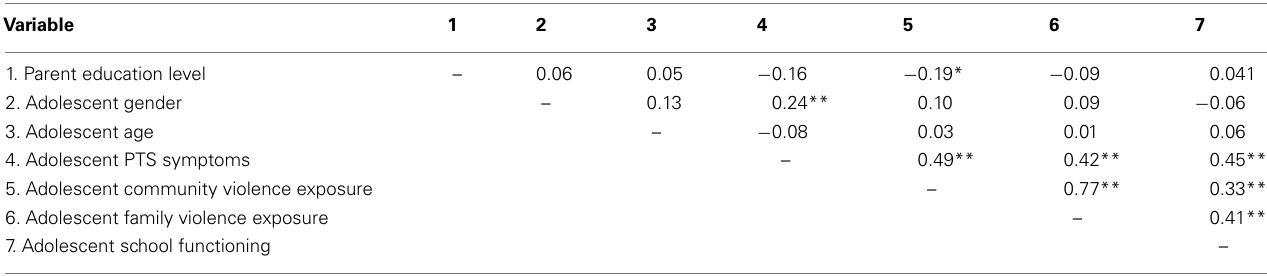
Table 1 | Correlation matrix for study